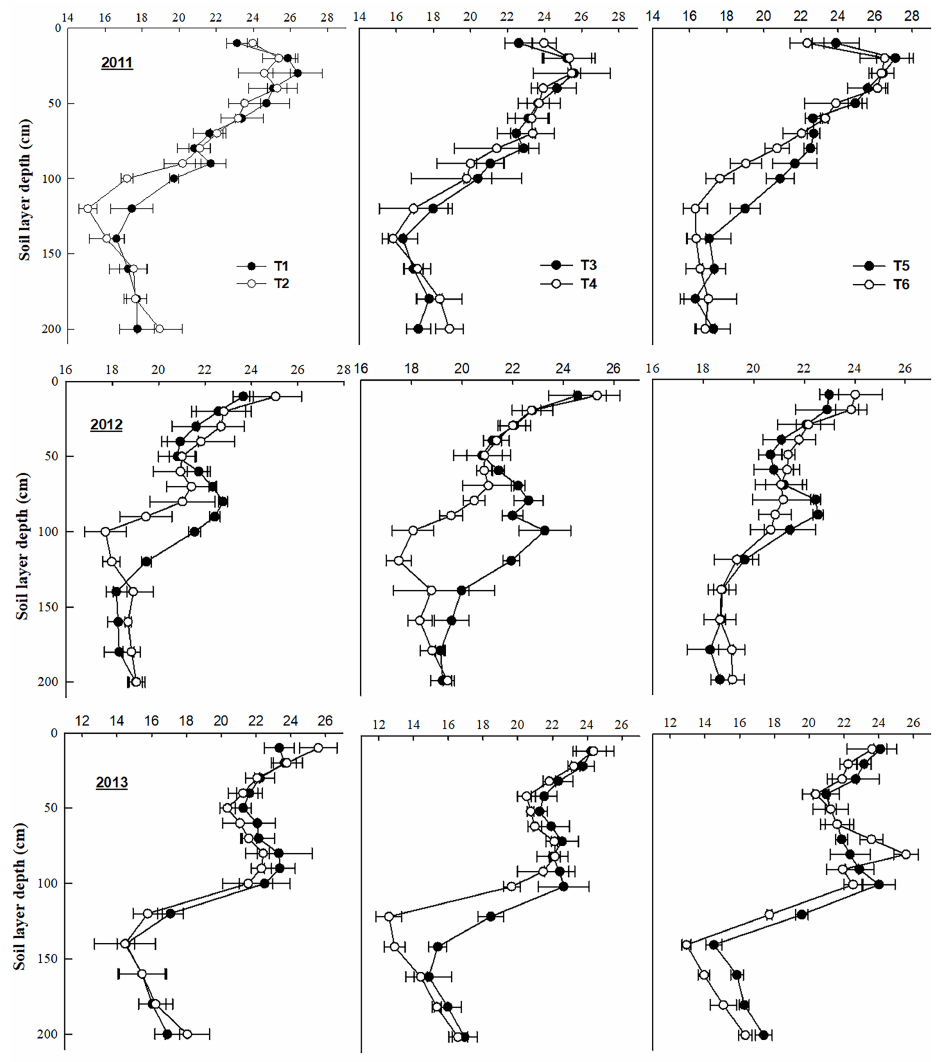
Figure 3. Different effects of organic manure on soil water content on